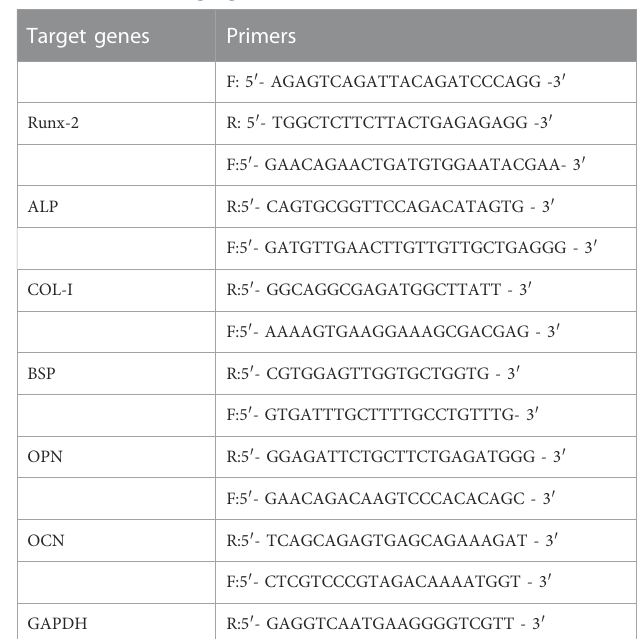
TABLE 1 Primers of target